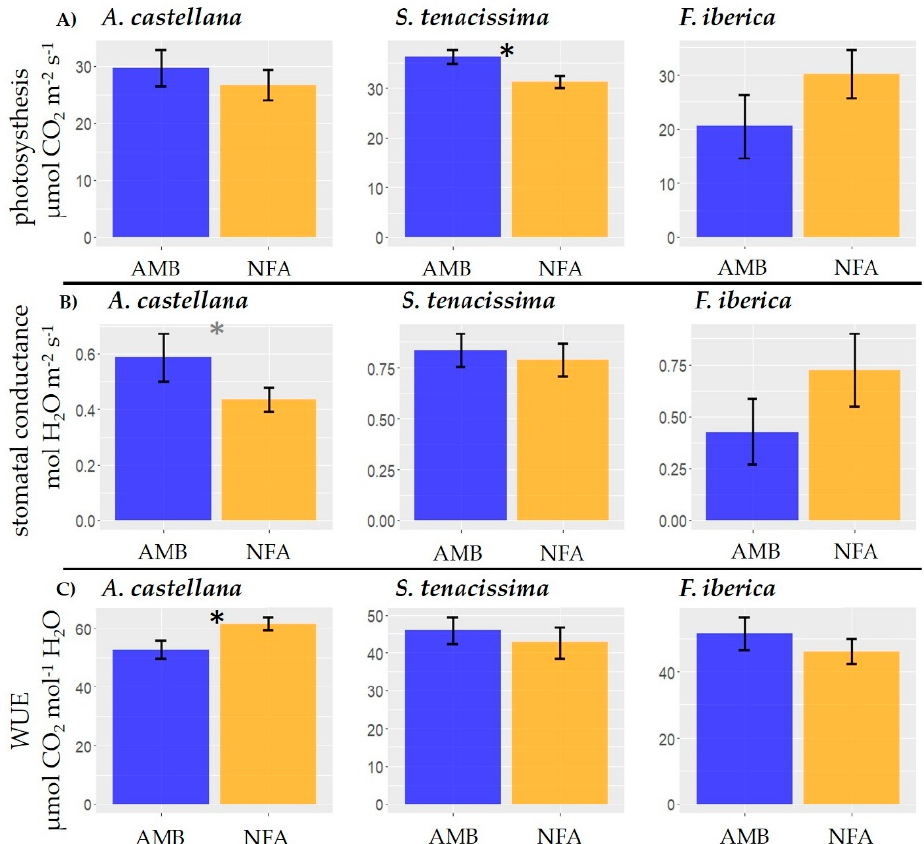
Figure 3. Temperature effects on gas exchange parameters: photosynthesis ( A , µ mol CO 2 m − 2 s − 1 ) ( A ), stomatal conductance (g s , mol H 2 O m − 2 s − 1 ) m ( B ) and water use efficiency (WUE, µ mol CO 2 mol − 1 H 2 O) ( C ) for A. castellana , S. tenaccissima , and F. iberica. Bars denote mean ± SE. Temperature treatments: low temperature (AMB plots), high temperature (NFA OTC). Black and grey asterisk denote significant and marginally significant differences, respectively.